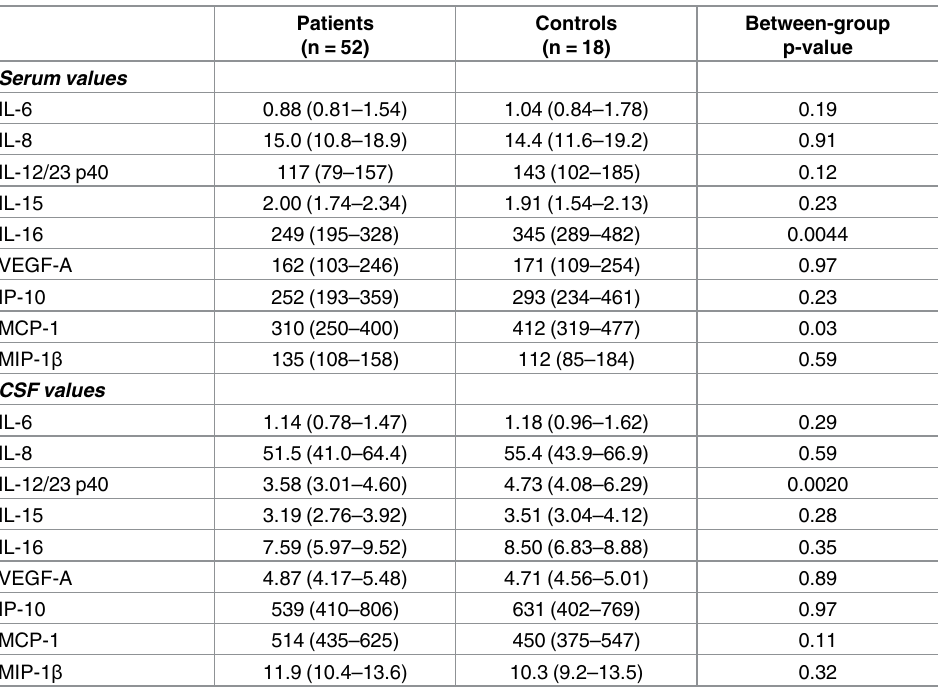
Table 1. Serum and CSF levels of cytokines and chemokines (pg/mL) in 52 patients with cognitive impairment and 18 healthy matched controls.